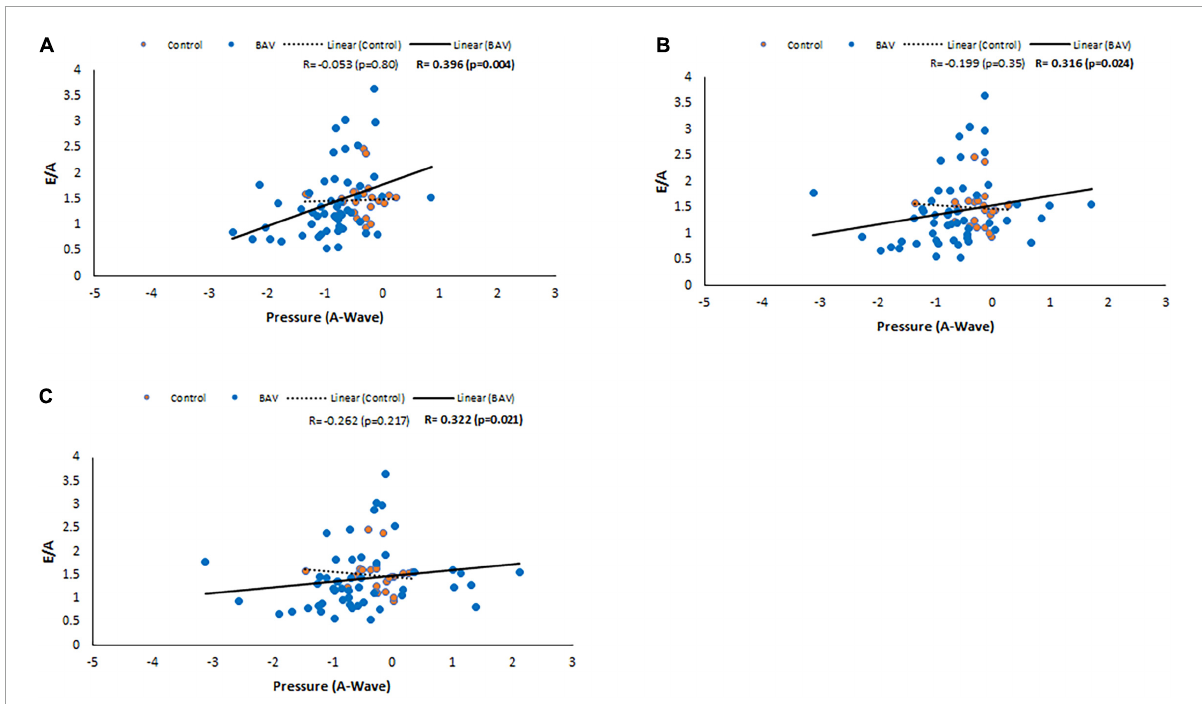
FIGURE7 E/A correlations with pressure at A-wave timepoint in control and BAV groups. The locations are shown at (A) MV, (B) LV middle part, and (C) LV apex. Left atrium (LA), mitral valve (MV), and left ventricle (LV).